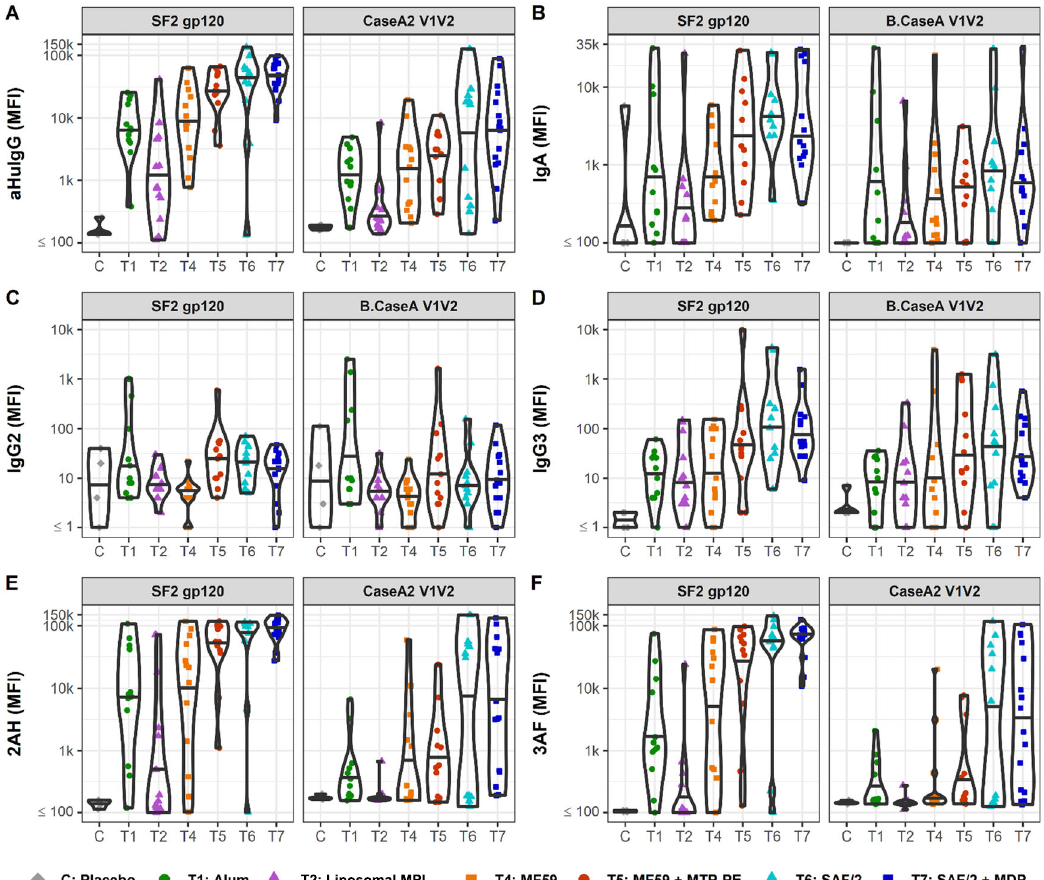
Fig. 3 Antibody responses at 2 weeks past fi nal vaccine. A – F Fc Array characterization of antibodies raised against SF2 and Case AV1V2. The isotype and subclass ( A – D ) and Fc γ receptor binding ( E , F ) pro fi les of HIV-speci fi c antibodies are presented. 2AH indicates binding to Fc γ RIIAH, and 3AF indicates binding to Fc γ RIIIAF. Median fl uorescence intensity (MFI) values for antibodies from individual vaccine recipients are indicated by dots, and violins plots present group distributions, with median values indicated with a